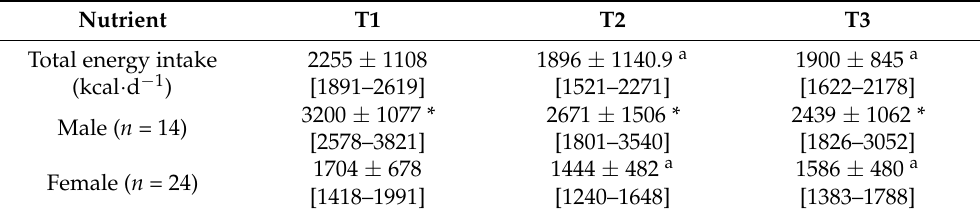
Figure 2. Body mass, lean body mass, fat mass, and body fat percentage levels (mean ± standard deviation) in undergraduate university students at the beginning of 1st year (1), the end of 1st year (2), and the end of 4th year (3). Notes: a, denotes significant difference from the beginning of 1st year ( p ≤ 0.05); b, denotes significant difference from the end of 1st year to the end of 4th year ( p ≤ 0.05) in pairwise post hoc comparisons. Table 1. Total daily energy, fat, protein, and carbohydrate consumption in undergraduate university students at the beginning of 1st year (T1), end of 1st year (T2), and end of 4th year (T3). Values are mean ± standard deviation [95% confidence